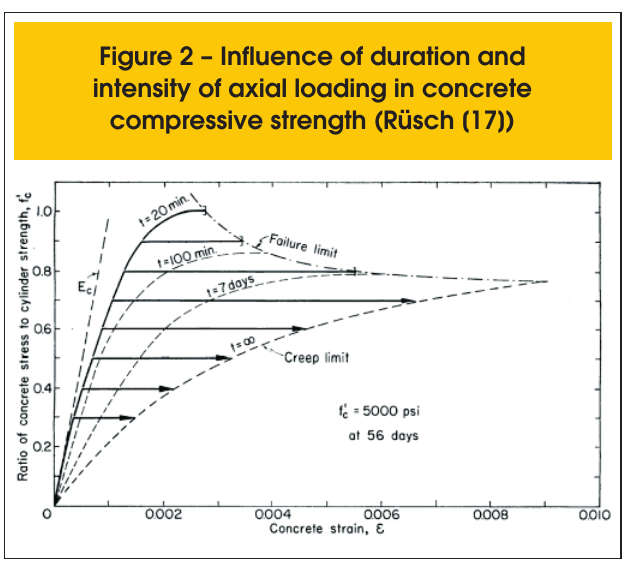
Figure 3 – Effects of age of loading in concrete compressive strength